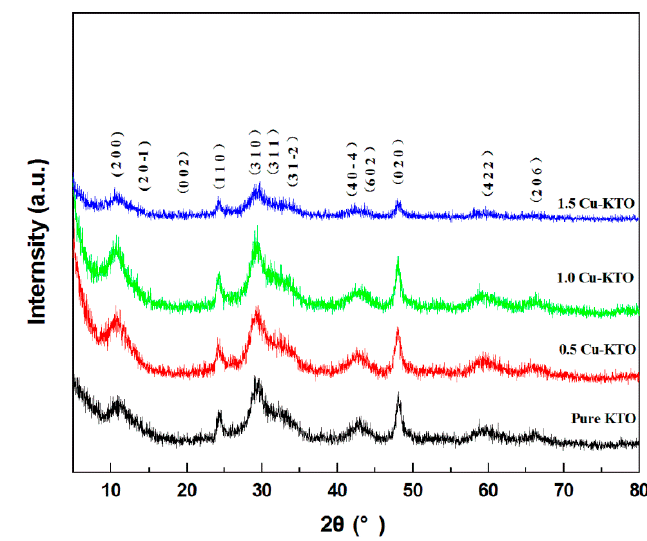
Figure 1. XRD spectra of KTO and Cu–KTO nanowires with different Cu doping amounts.